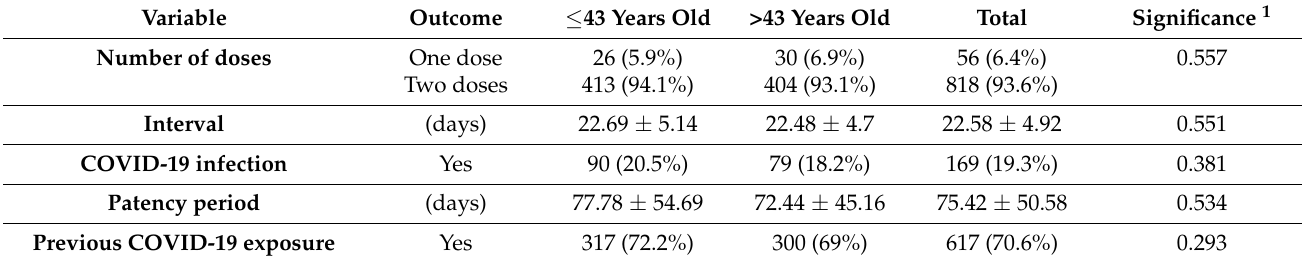
Table 5. COVID-19-related anamnesis of vaccinated healthcare workers in the Czech Republic, January–February 2021. Variable Outcome Number of